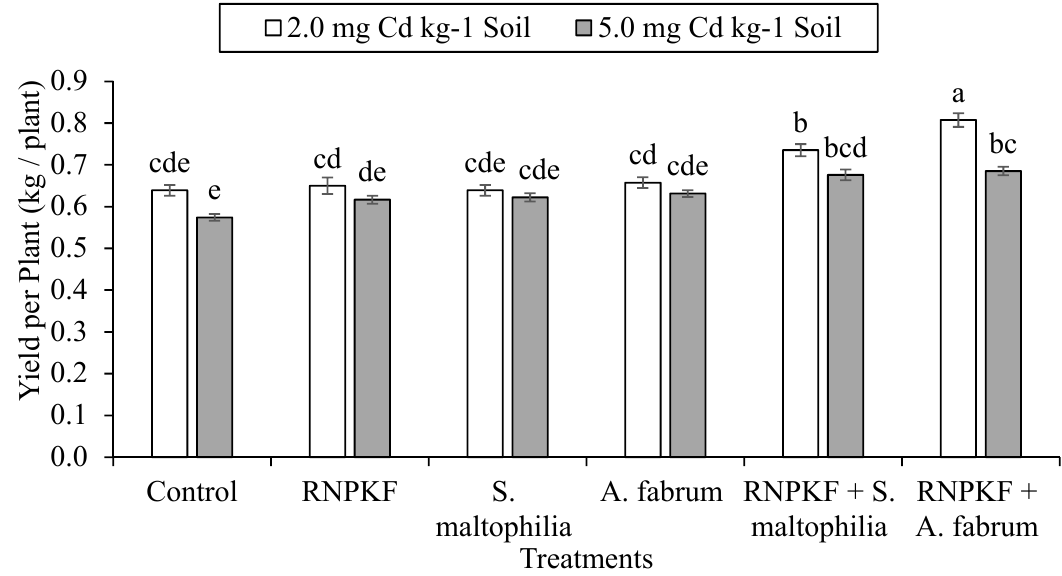
Figure 6. Bitter gourd yield (kg) per plant treated with PGPRs, RNPKF, and their combination under 2 and 5 mg Cd kg − 1 soil. Different small letters express significant differences at p ≤ 0.05.